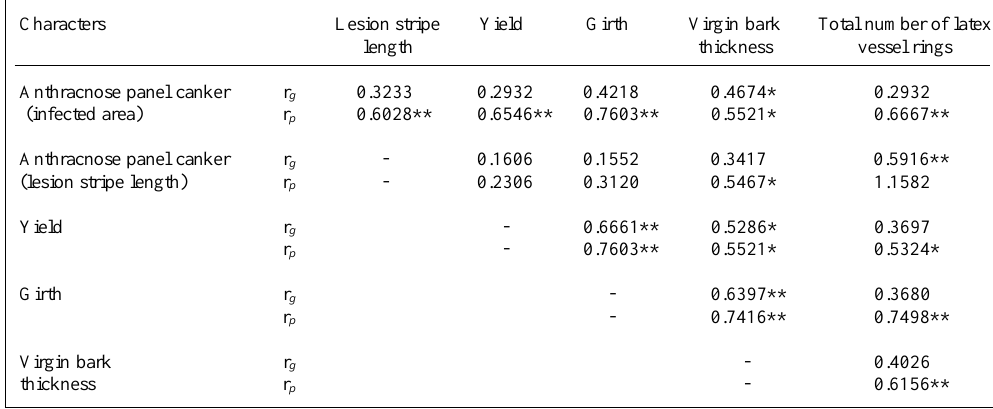
Table VII - Estimates of genotypic (r ) and phenotypic (r ) correlation coefficients, based on individual trees among g p anthracnose panel canker disease yield and growth characters of 18 open-pollinated progenies of rubber tree (Hevea brasiliensis)